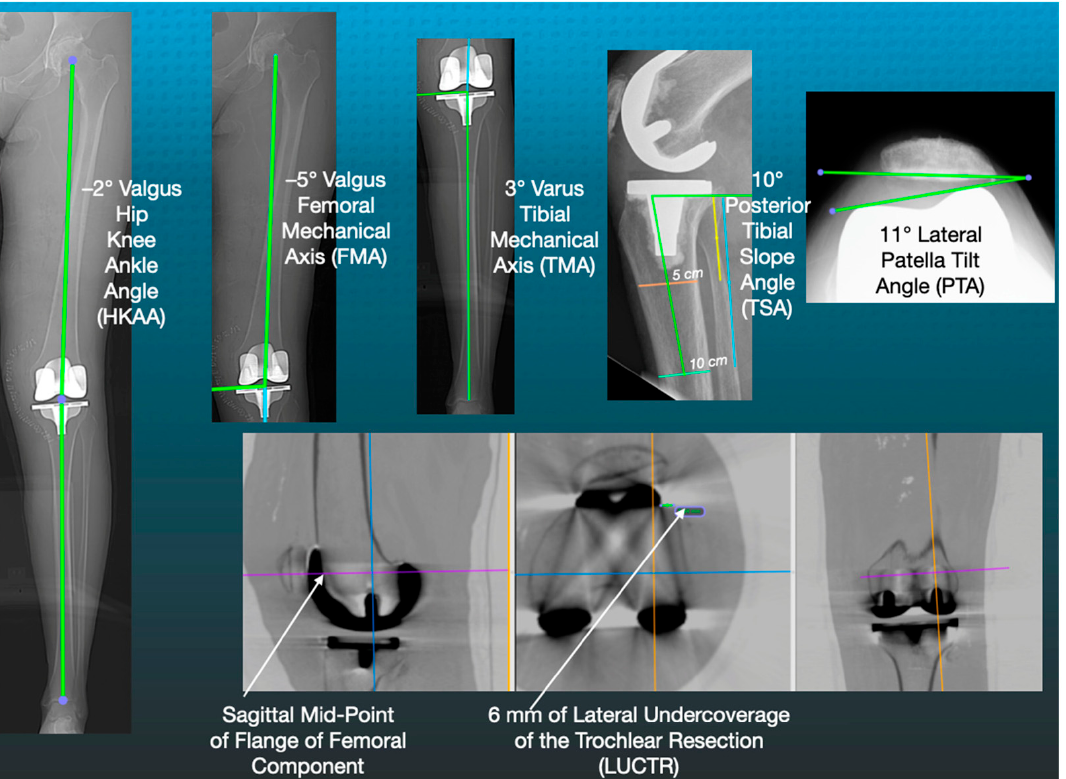
Figure 1. Images of a patient’s left lower limb show the landmarks for measuring the six commonly used radiographic parameters, which were − 2 ◦ valgus for the HKAA, − 5 ◦ valgus for the FMA, 3 ◦ varus for the TMA, 10 ◦ for the TSA, 11 ◦ lateral tilt for the PTA, and 6 mm of lateral undercoverage of the trochlear resection at the sagittal midpoint of the flange of the femoral